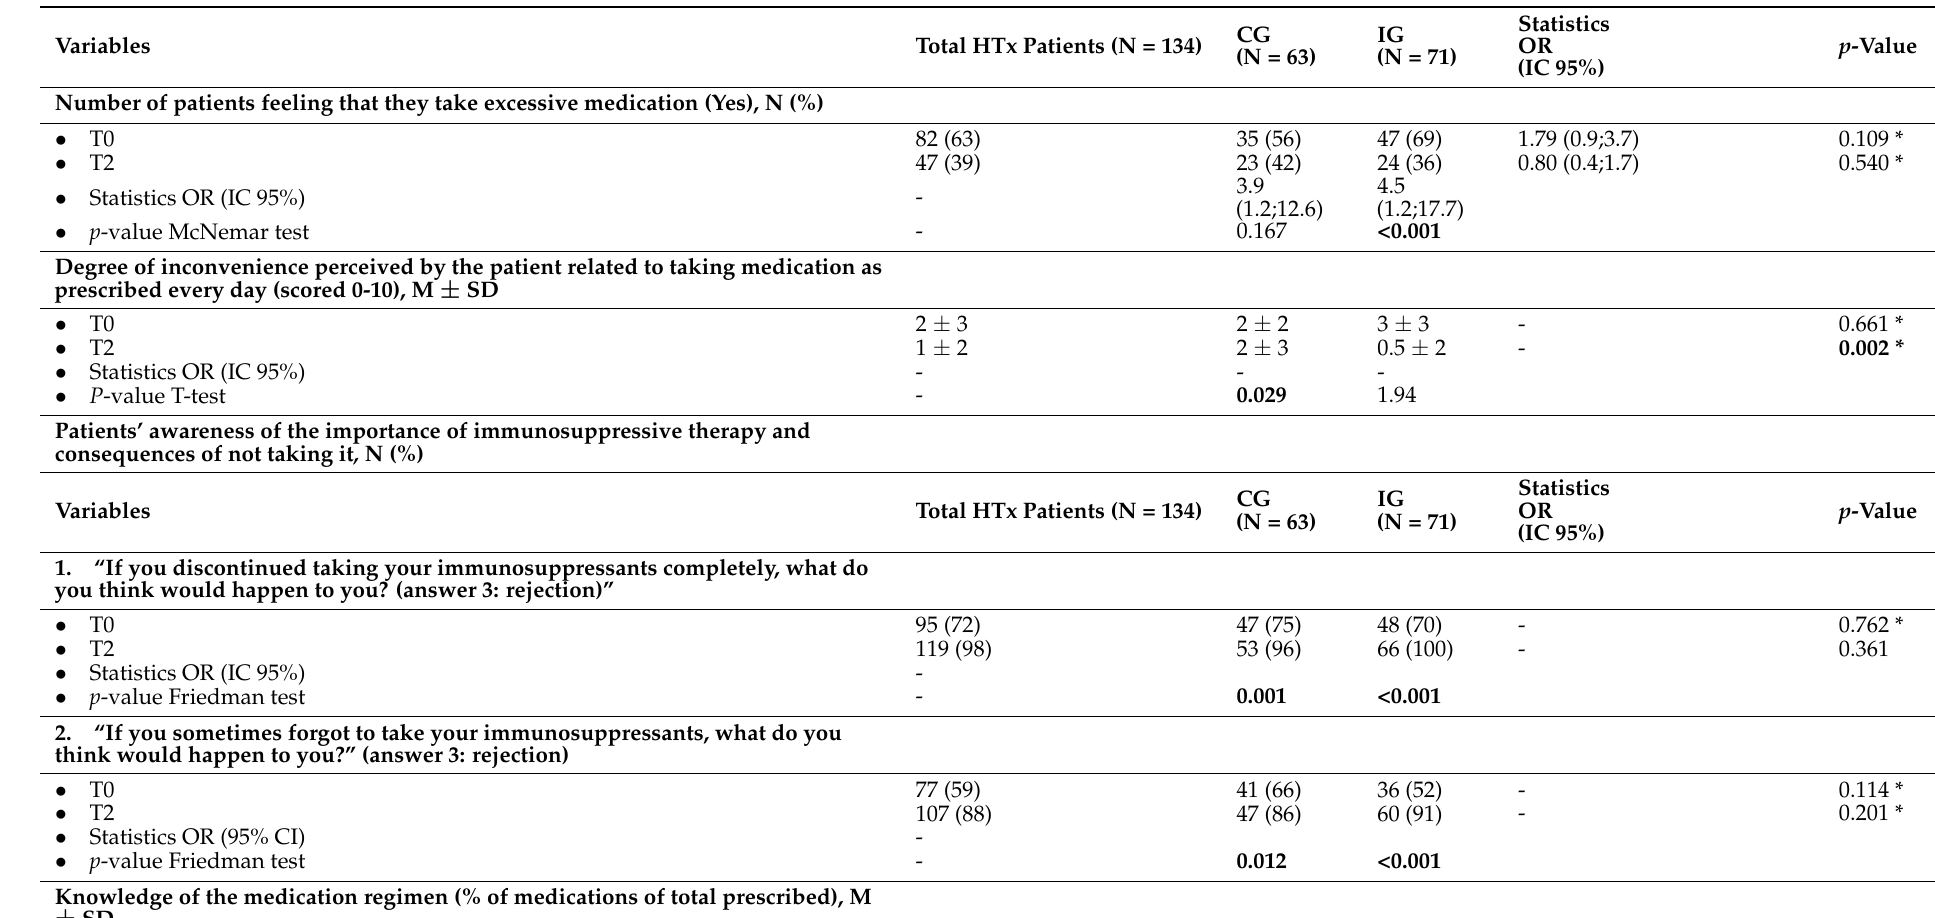
Table A2. Improvement in patient-experience measures over time (T0 vs. T2) and between control (CG) vs. intervention (IG)